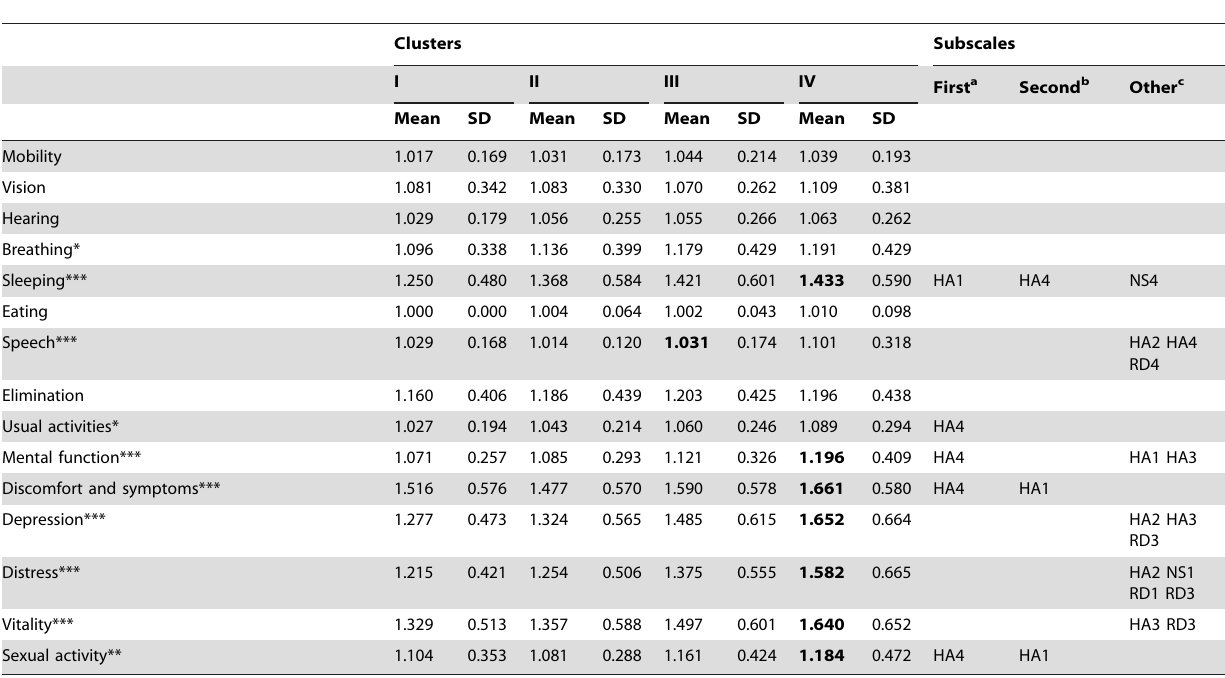
Table 2. Means and standard deviations from 15D questionnaire for females.